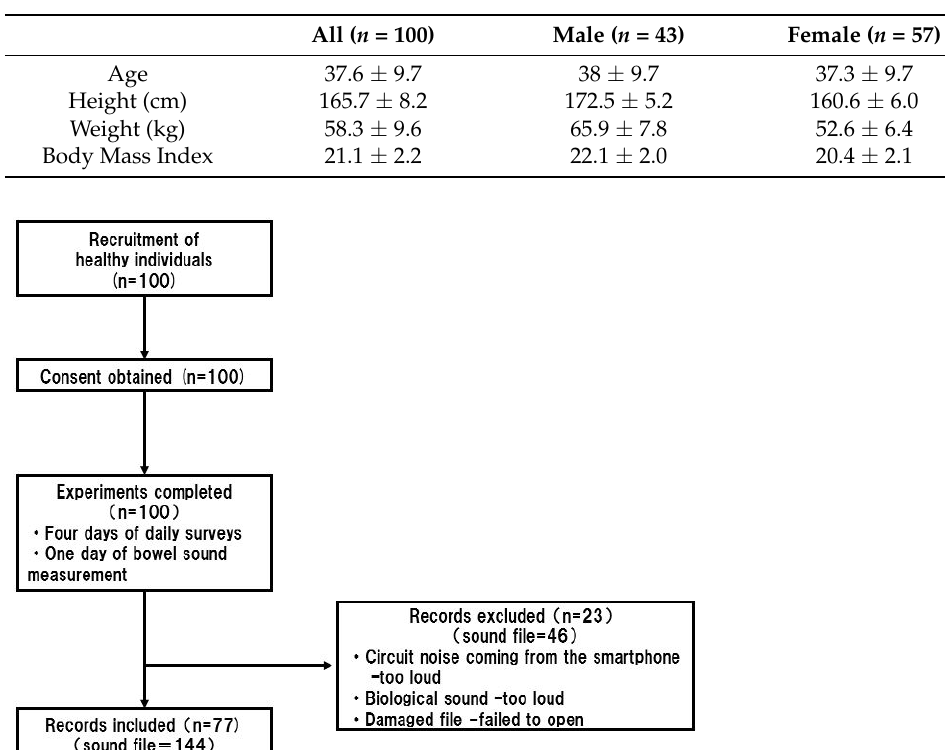
Table 1. Study participant characteristics.